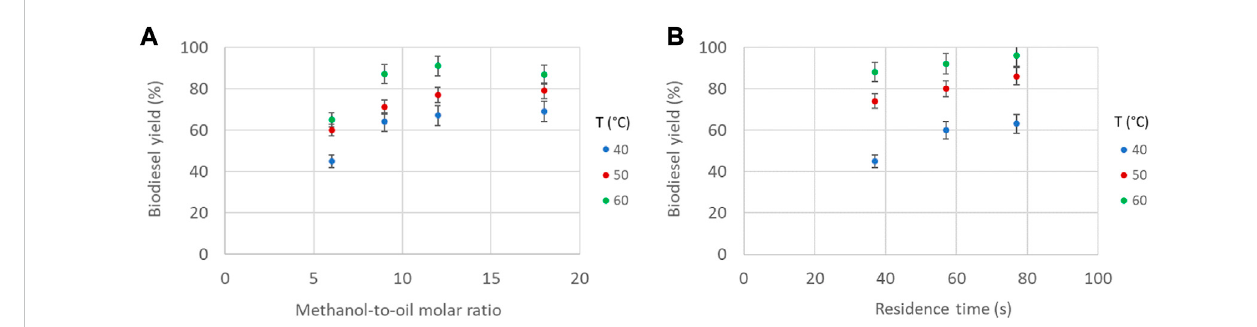
FIGURE 8 Biodiesel yield as afunction of (A) methanol-to-oilmolar ratioand temperature(constant residence time 70 s,constant catalystconcentration 1.4% w/w) and (B) residence time and temperature. (Constant molar ratio 10, constant catalyst concentration 1.8% w/w).